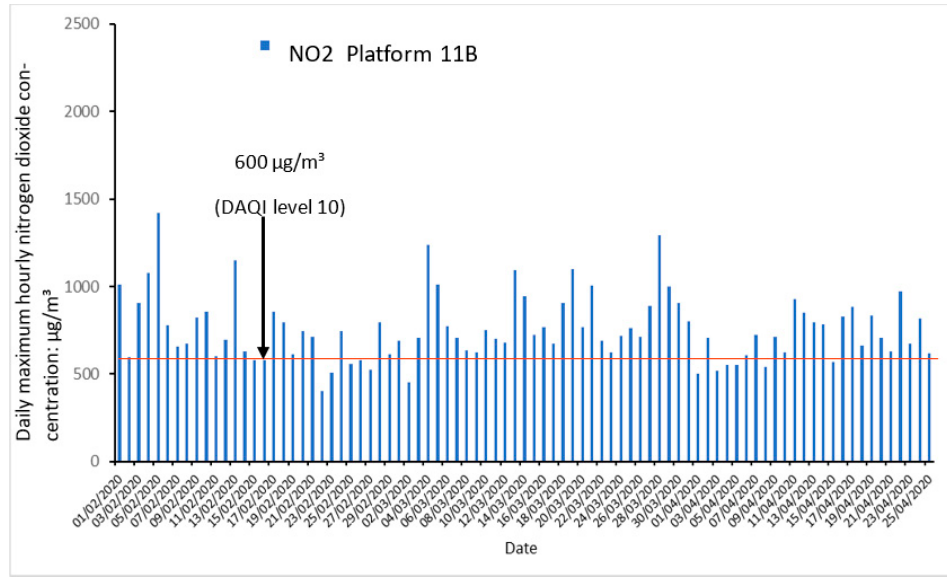
Figure 4. Retrospective assessment of the Daily Air Quality Index (DAQI) (73 out of 85 days (86%) exceeding DAQI level 10), for nitrogen dioxide concentrations in Birmingham New Street Station on Platform 11B.